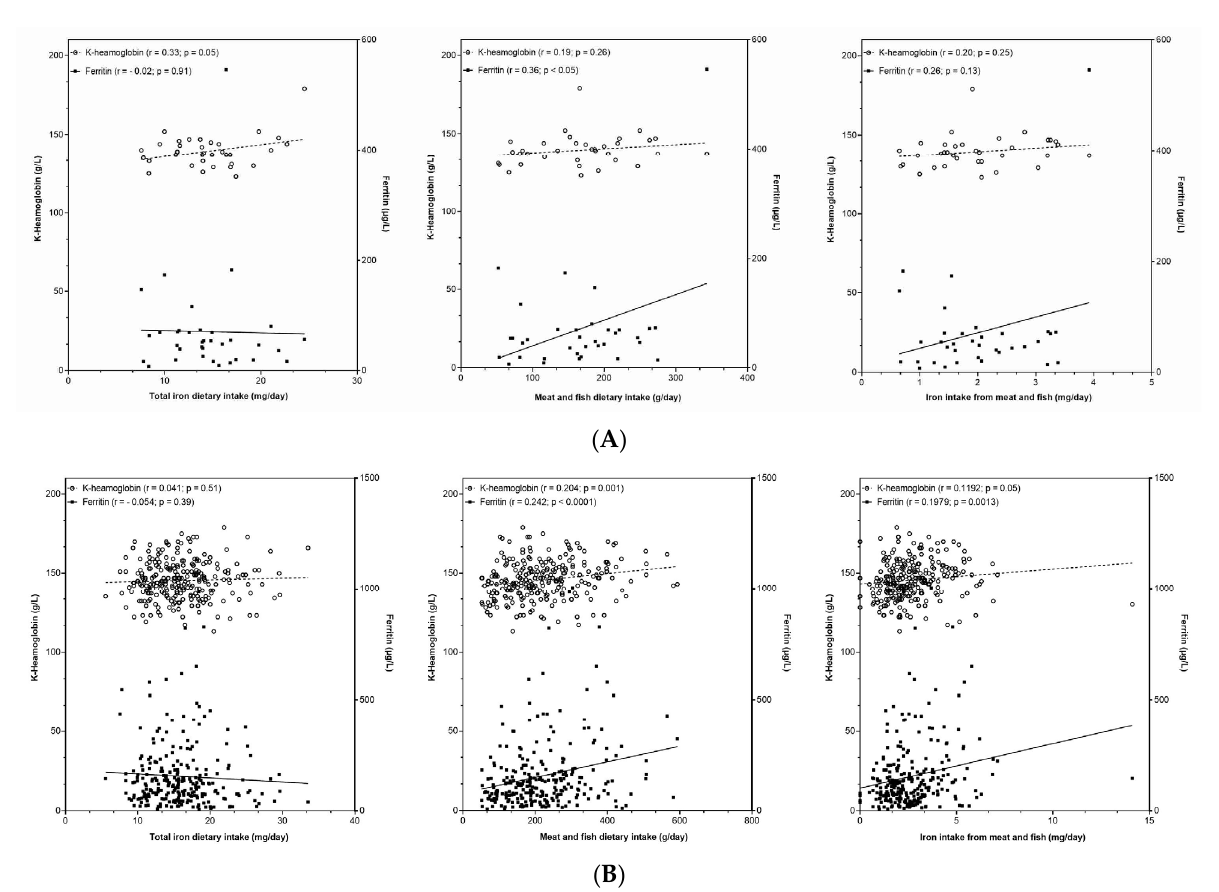
Figure 3. ( A ) Association between haemoglobin and ferritin concentration with ( left ) total iron dietary intake, ( centre ) meat and fish dietary intake, and ( right ) iron intake from meat and fish in Nutrihealth sample, with exclusion of subjects using iron food supplement. ( B ) Association between haemoglobin and ferritin concentration with ( left ) total iron dietary intake, ( centre ) meat and fish dietary intake, and ( right ) iron intake from meat and fish in Nutrihealth sample, with the exclusion of subjects using iron food